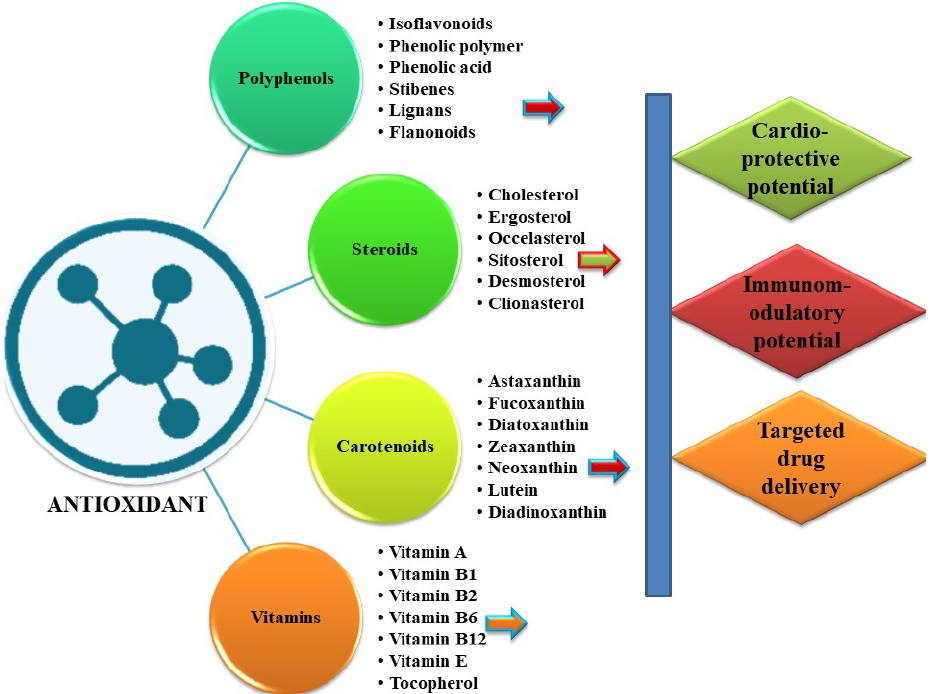
Figure 3. An overview of the diversity of physiologically active antioxidants produced in algae and their possible therapeutic and biological potential.